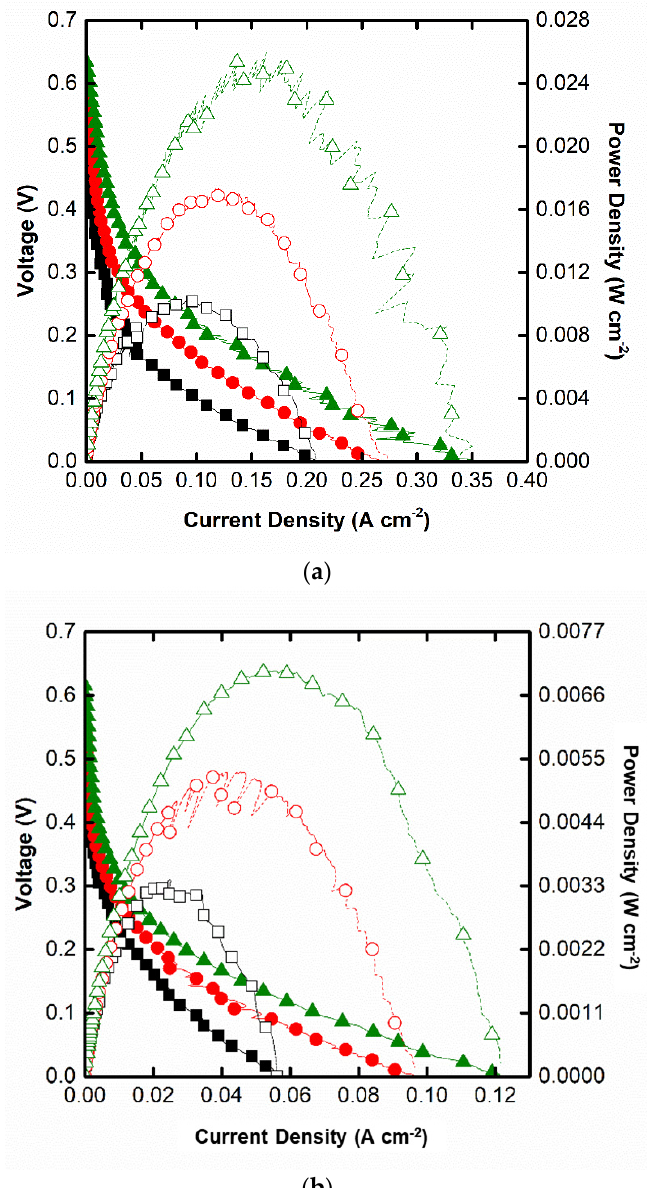
Figure 4. Polarization curves for: ( a ) PBI-based DFAFC; and ( b ) PBI-based DEFC for different temperatures ( (cid:4)(cid:3) : 150 ◦ C, • : 175 ◦ C, (cid:78) (cid:52) : 200 ◦ C; solid symbols: cell voltage, hollow symbols: cell power output; anode and cathode prepared by the hydrothermal reduction).